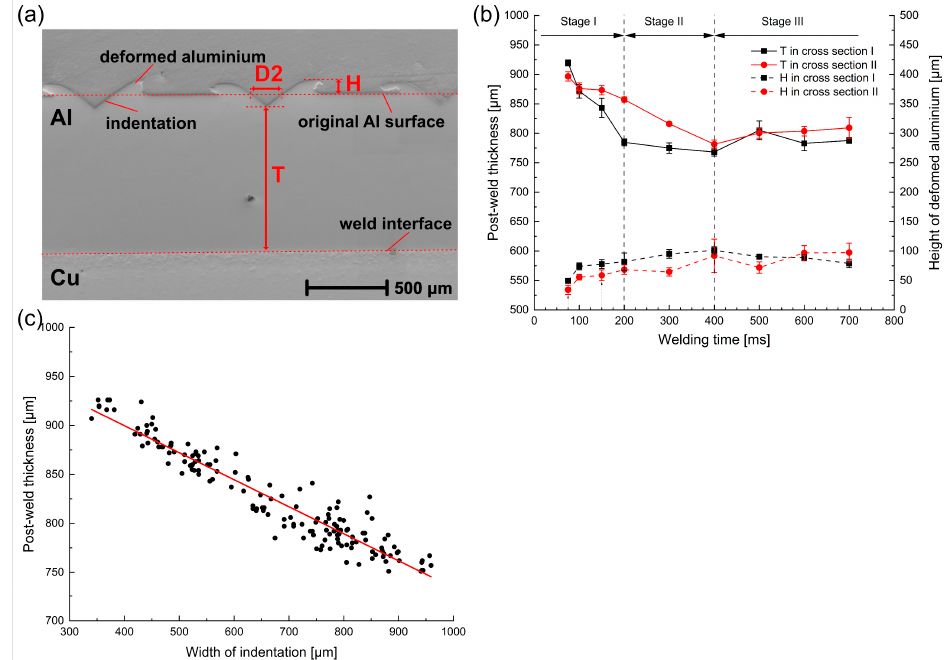
Figure 4. Optical micrographs of cross-sections for the Al/Cu joint at different welding time: ( a – d ) cross-section I; ( e – h ) cross-section II.